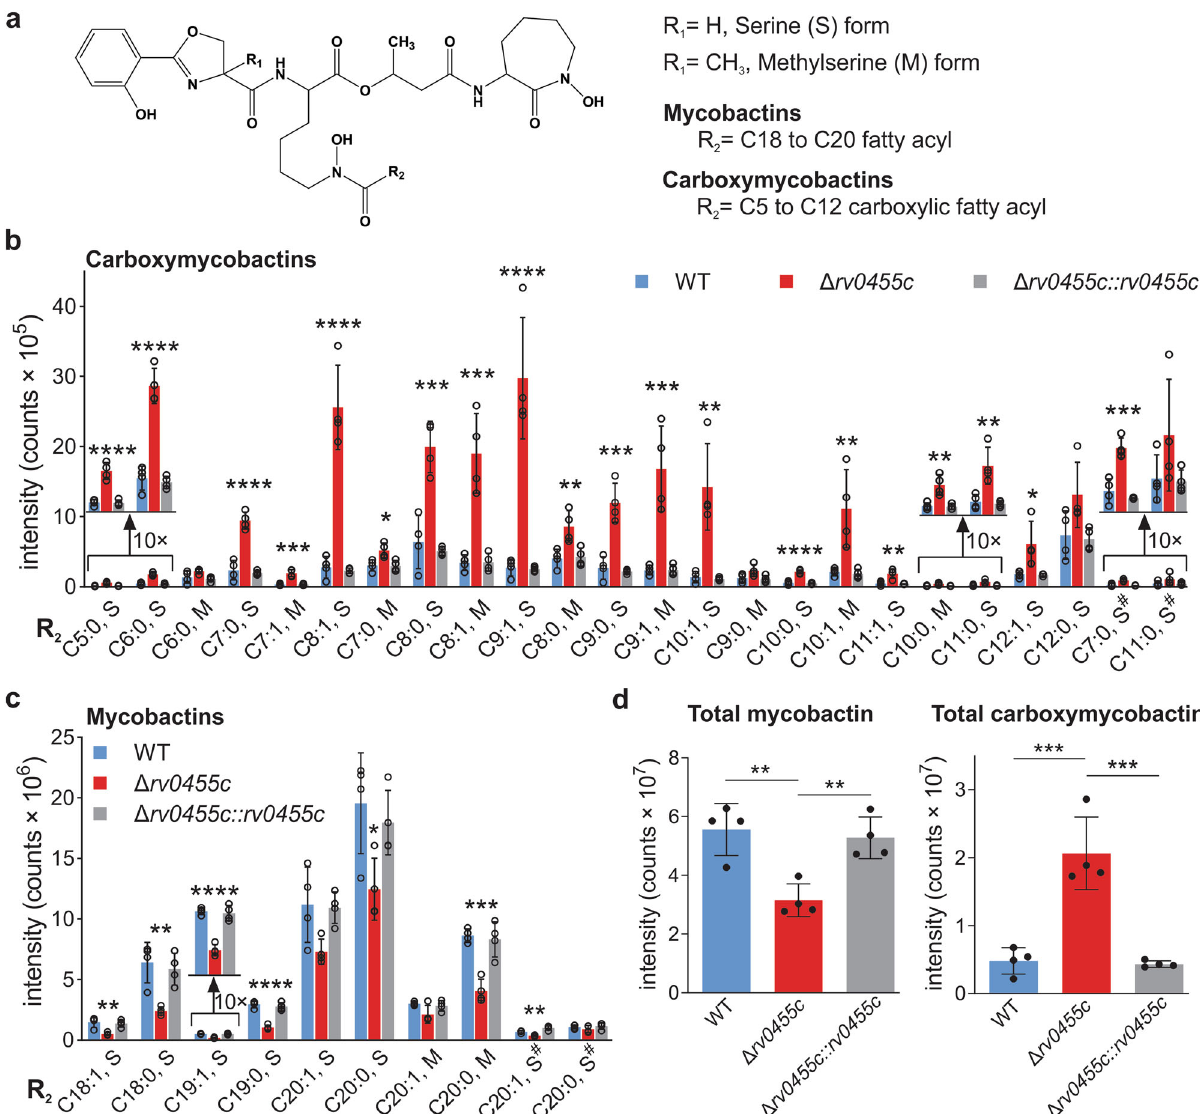
Fig. 4 Siderophore pro fi le of the M. tuberculosis Δ rv0455c mutant. Whole-cell lipid extracts of M. tuberculosis mc 2 6230, the Δ rv0455c mutant, and the Δ rv0455c mutant complemented with an integrated rv0455c expression vector were analyzed by lipidomics using high-performance liquid chromatography and mass spectroscopy. a Chemical structure of the core of M. tuberculosis siderophores. R 1 : H or CH 3 represent the serine (S) or methylserine (M) form, respectively. R 2 : alkyl chains. The mean intensity values for molecular events are shown for a subset of carboxymycobactin isoforms ( b ) and mycobactin isoforms ( c ). The indicated fatty acid chain lengths (number of carbons) and the number of double bonds corresponding to mono- or di-carboxyl units assume the peptide structure shown in ( a ), which according to prior analyses is the dominant form 12,55 . The monodeoxy-mycobactins and monodeoxy- carboxymycobactins are indicated with a hash tag ( # ). d Total mycobactin and total carboxymycobactin counts in wt M. tuberculosis (blue), the Δ rv0455c mutant ML2203 (red), and the complemented strain ML2205 (gray). Data are mean ± s.d. of four biological replicates. Asterisks indicate signi fi cant differences ( * p < 0.05, ** p < 0.01, *** p < 0.001, **** p < 0.0001 by one-way ANOVA with Tukey ’ s test) compared with wt M. tuberculosis . Source data are provided in the Source Data fi